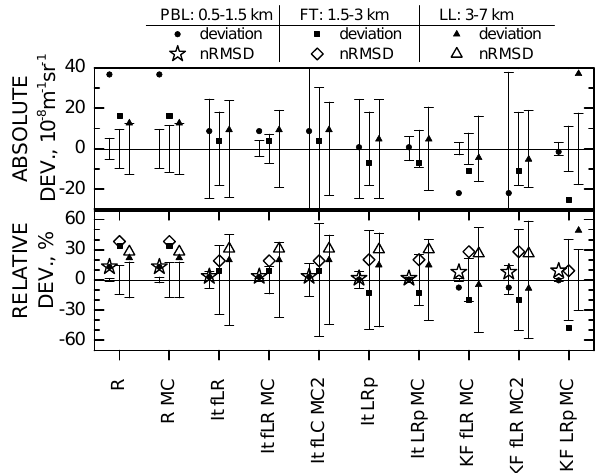
Figure 12. Same as Fig. 11 but for particle backscatter coefficient profiles at 355nm. The fixed lidar ratio value was set to 51sr with an uncertainty of ± 10sr.